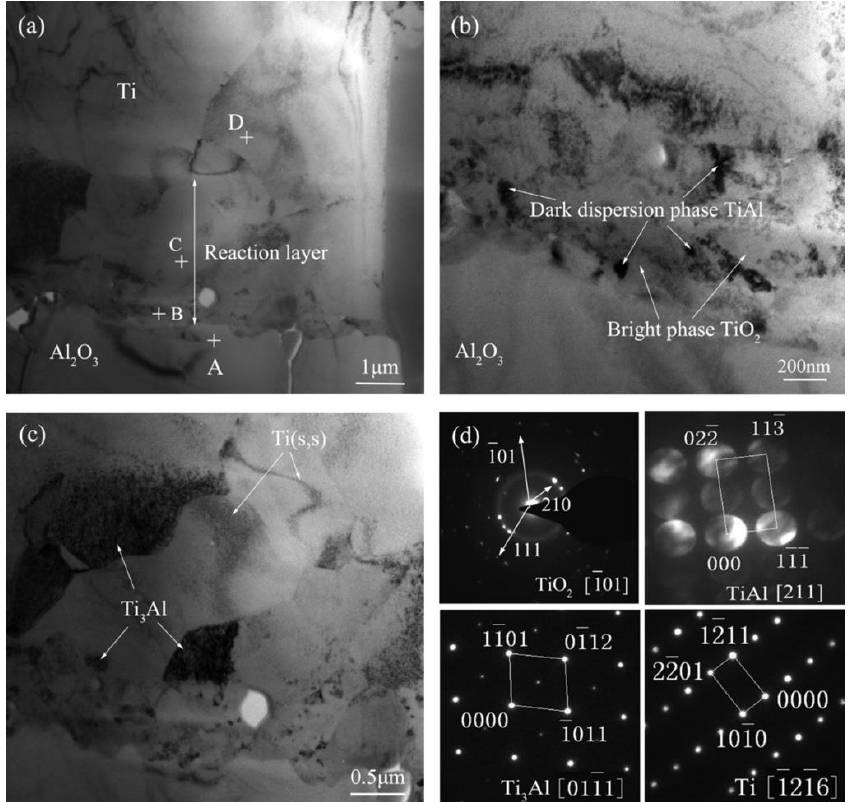
Figure 19. TEM images of the Ti/Al 2 O 3 joint bonded at 900 °C for 60 min under 700 V. ( a ) The morphology of the reaction layer; ( b ) magnified zone B; ( c ) magnified zone C; ( d ) electron diffraction (SAED) patterns of the phases, reproduced from Reference [46] with permission of Elsevier, 2015. Metals 2018 , 8 , x FOR PEER REVIEW